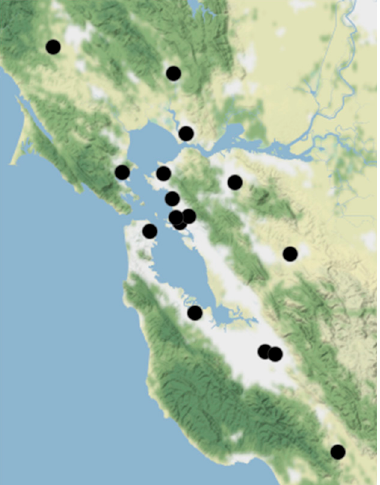
Figure 1. Map displaying the locations of Bay Area Air Quality Management District (BAAQMD) ground-level monitors measuring particulate matter <2.5 μ m in diameter (PM 2.5 ) that were included in the analysis (N = 16). (Map tiles by Stamen Design, CC BY 3.0).